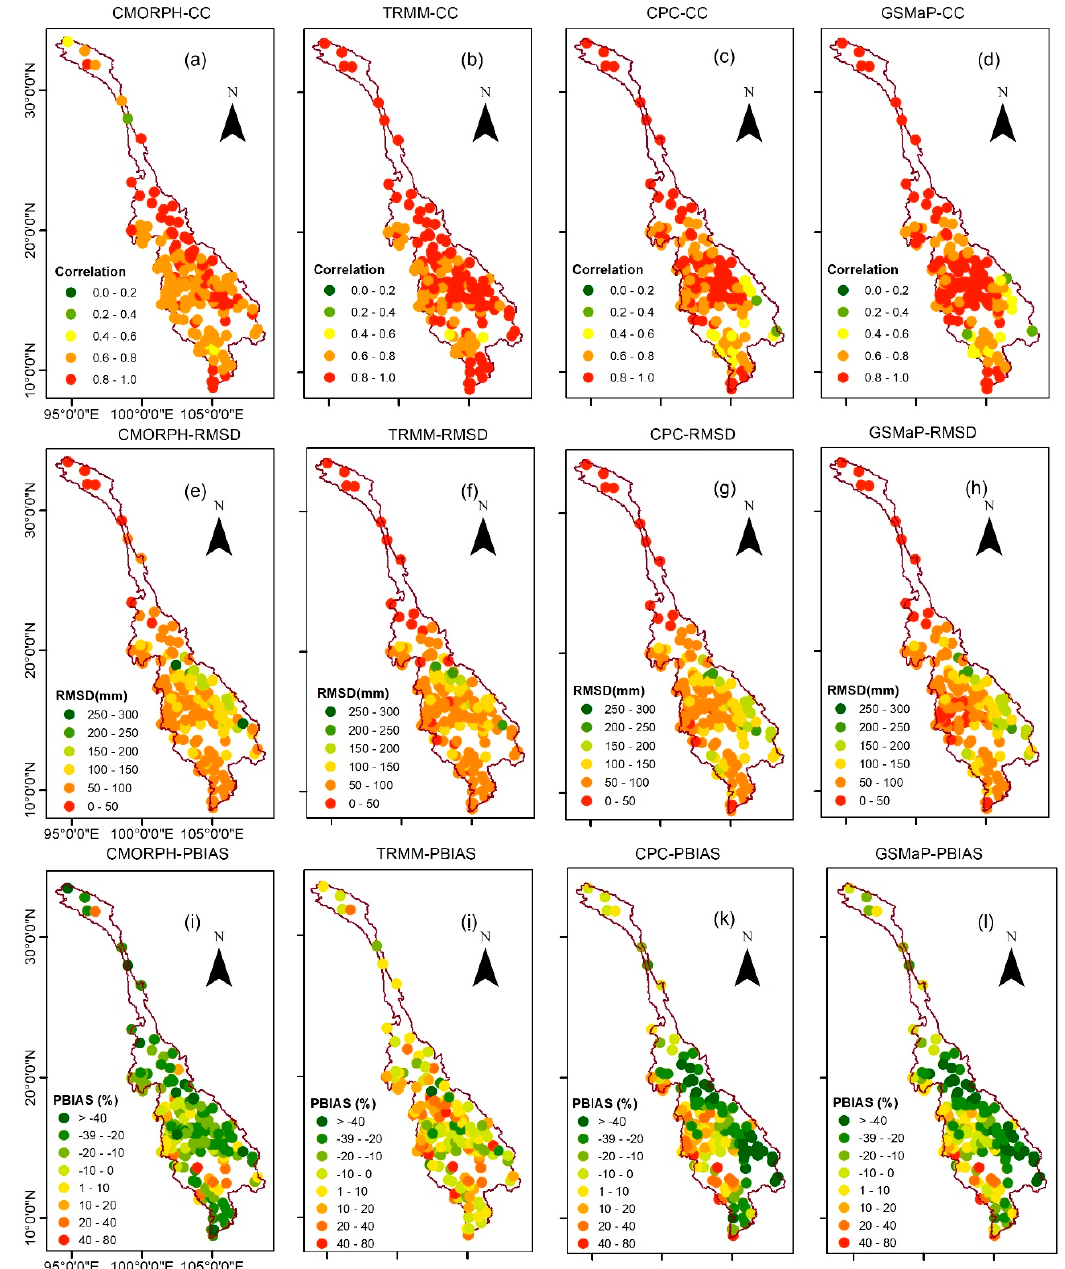
Figure 3. Spatial distributions of the correlation coefficient (CC) ( a – d ), the root-mean-squared deviation (RMSD) (mm/month) ( e – h ), and the percentage bias (PBIAS) (%) ( i – l ) between the GPPs and the gauge observations at the monthly scale during 1998–2006.